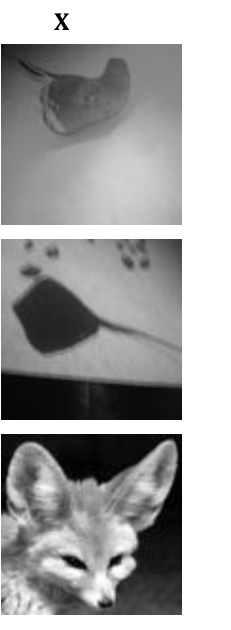
Figure 3. Visual quality comparisons of three images from Tiny-ImageNet. X, (cid:101) X, X (cid:48) at the sampling rate 0.1 are indicated from the first to the fifth column, respectively.